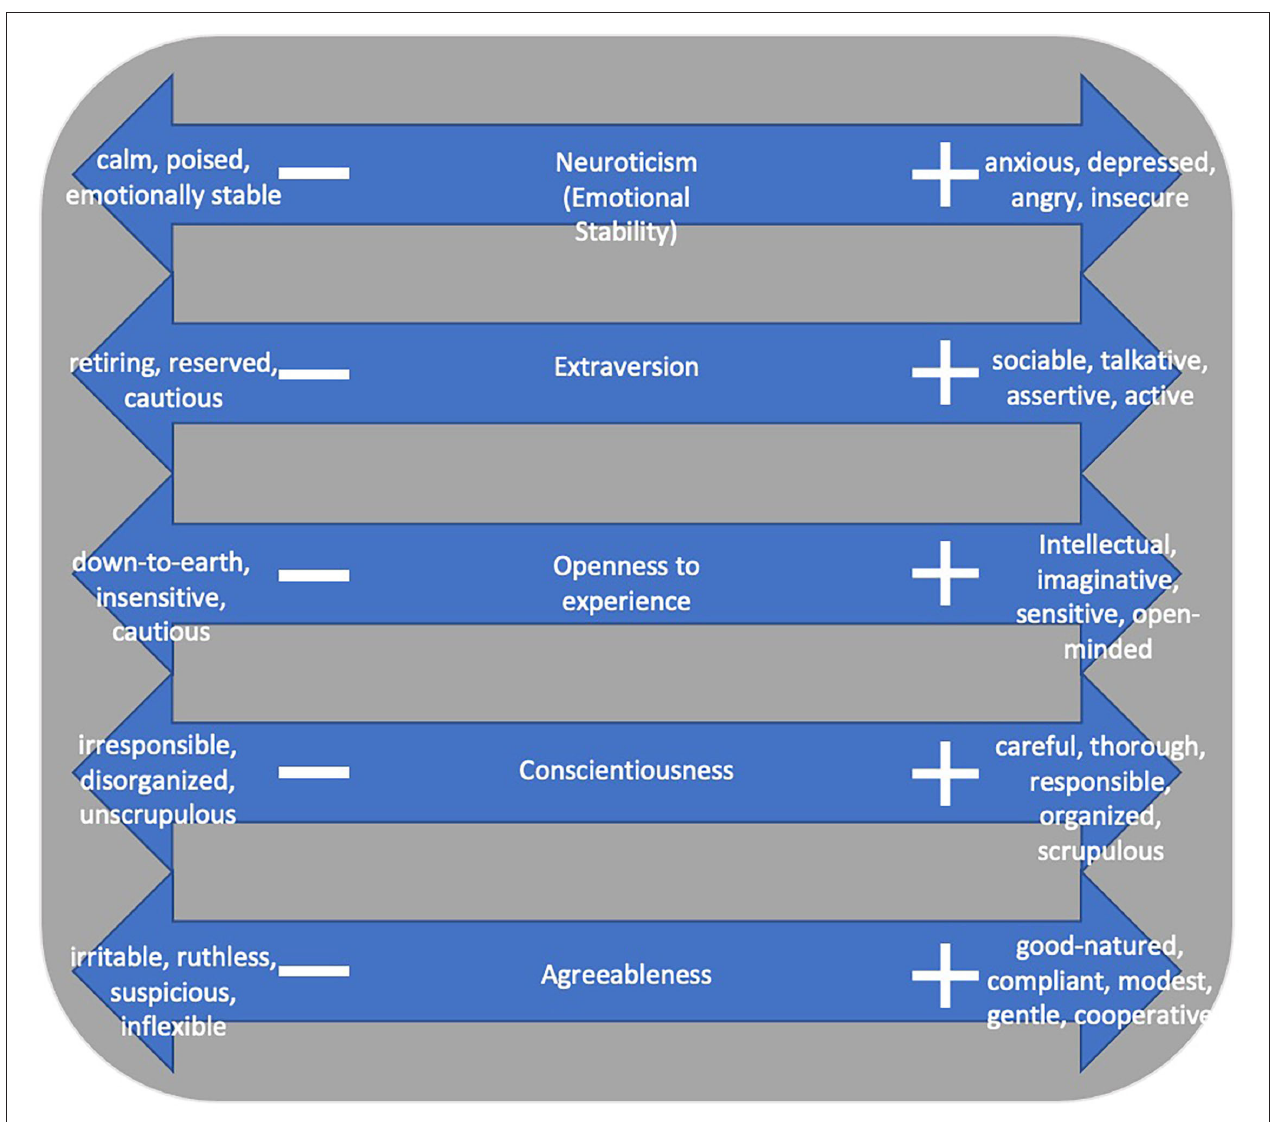
FIGURE 1 | Model of the Big Five personality traits (based on Roccas et al., 2002, p.